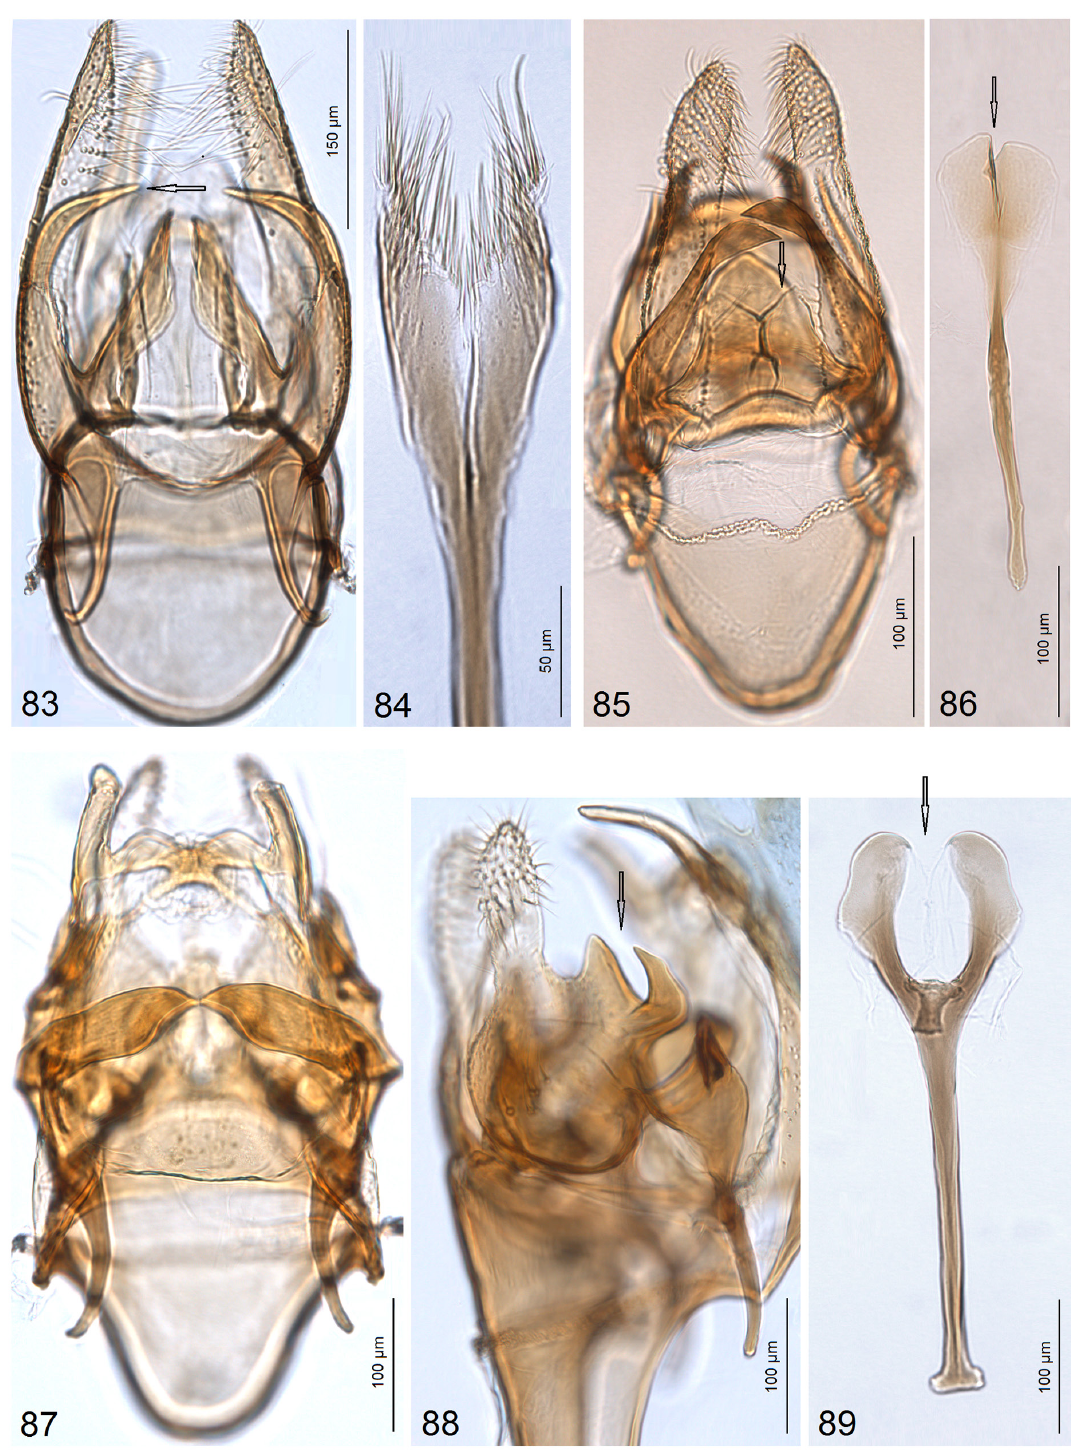
Figs 83–89. Male genitalia of Astrotischeria spp. (NHMUK). 83 . A. selvica Diškus, Carvalho-Filho & Stonis, 2018, capsule with phallus removed, holotype (genitalia slide no. AD920). 84 . Same, phallus, paratype (genitalia slide no. AD919). 85 . A. casila Diškus & Stonis, 2018, capsule with phallus removed, holotype (genitalia slide no. AD939). 86 . Same, phallus. 87 . A. furcata Diškus & Stonis, 2018, capsule with phallus removed, holotype (genitalia slide no. AD925). 88 . Same, lateral view of capsule. 89 . Same,